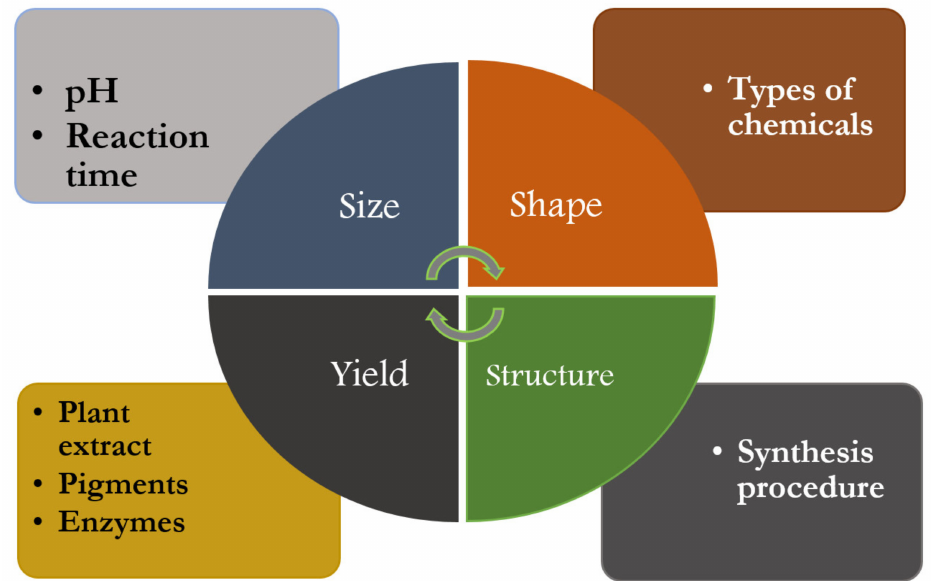
Figure 3. Different types of factors affecting the morphology of